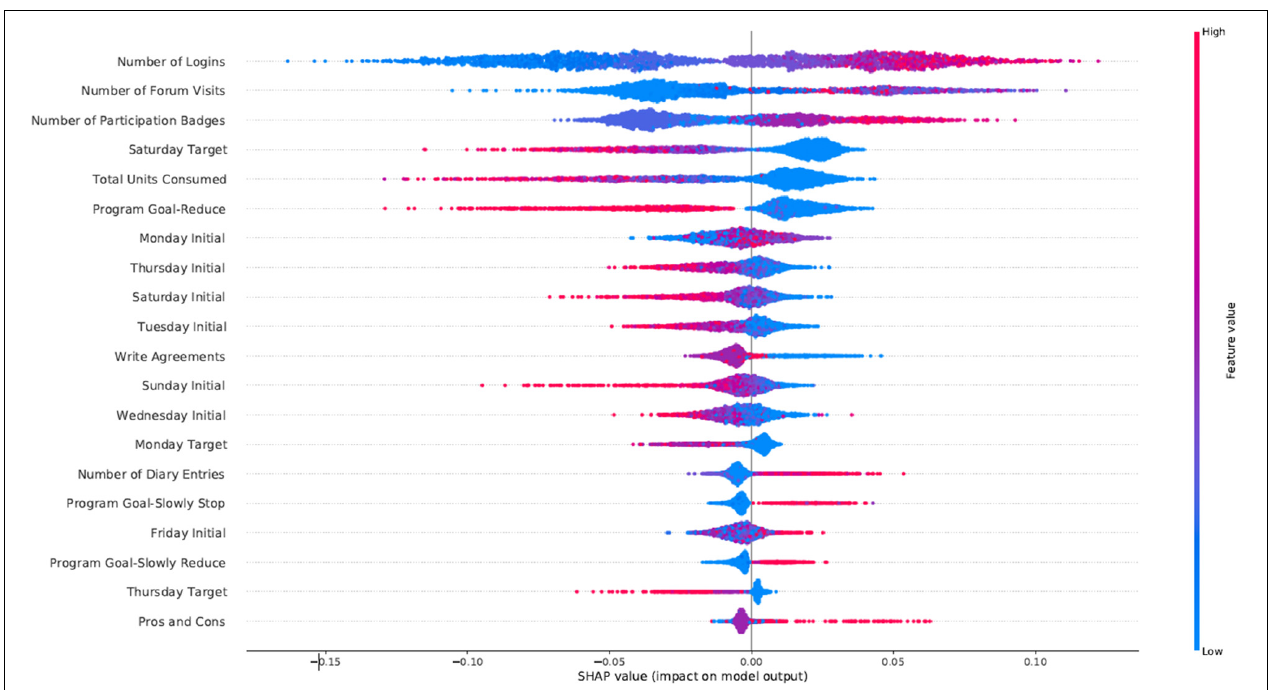
FIGURE 3 | SHAP feature importance for the alcohol intervention using the RFC model. For visualization purposes we included only the top 20 features. In the y -axis, we have the features based on the first 72 h of participation in order of importance from top (most important) to bottom (less important) and in the x -axis their respective SHAP value which indicates their association with success (SHAP values are above zero) or early dropout (SHAP values below zero) participant outcomes.